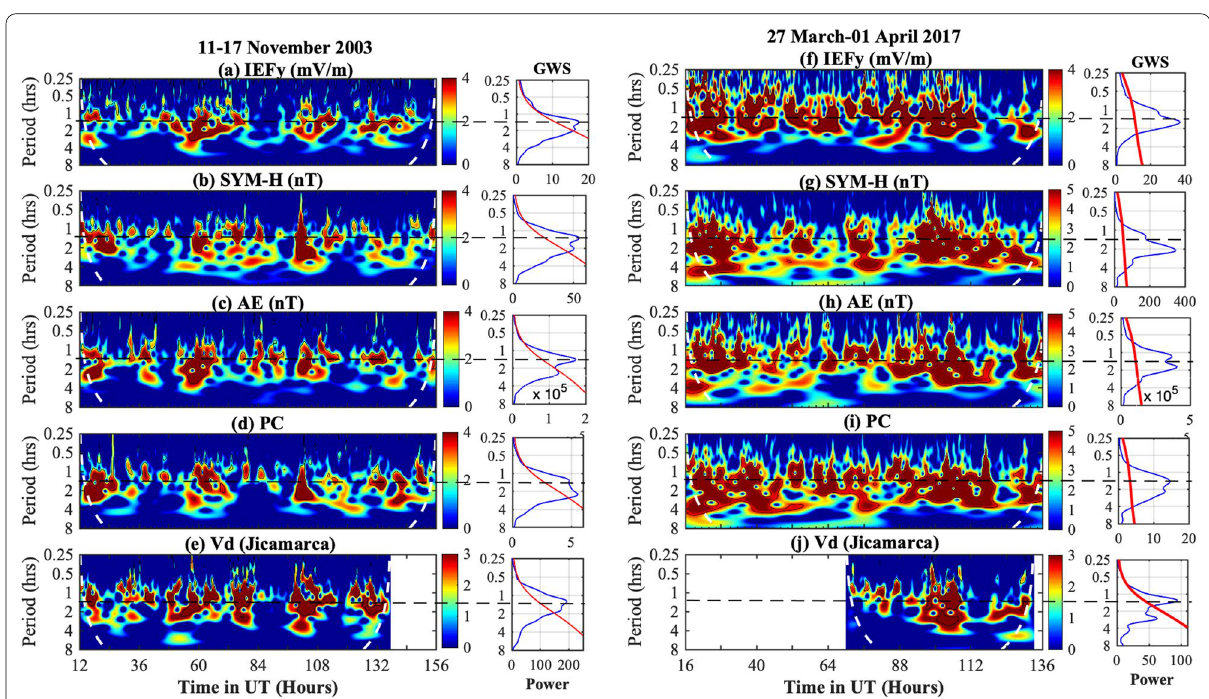
Fig. 2 Wavelet power spectra of time series of a IEFy, b SYM-H, c AE, d PC, and e V d from 12:00 UT, 11 November to 12:00 UT, 17 November 2003. The right panels show the wavelet spectra of corresponding parameters from 16:00 UT, 27 March to 16:00 UT, 01 April 2017. The corresponding power and GWS are also shown in each panel with 95% significance level (red line). The cone of influence (COI) is indicated by white-dashed lines. It is to be noted that the wavelet spectra for both events show the highest peak in the GWS at ∼ 1.5–2 h. The black dashed-line is marked at 1.5 h period. The concomitant occurrence of the 1.5–2 h periodicity in IEFy, SYM-H, AE, PC, and V d implies possible global oscillations during the